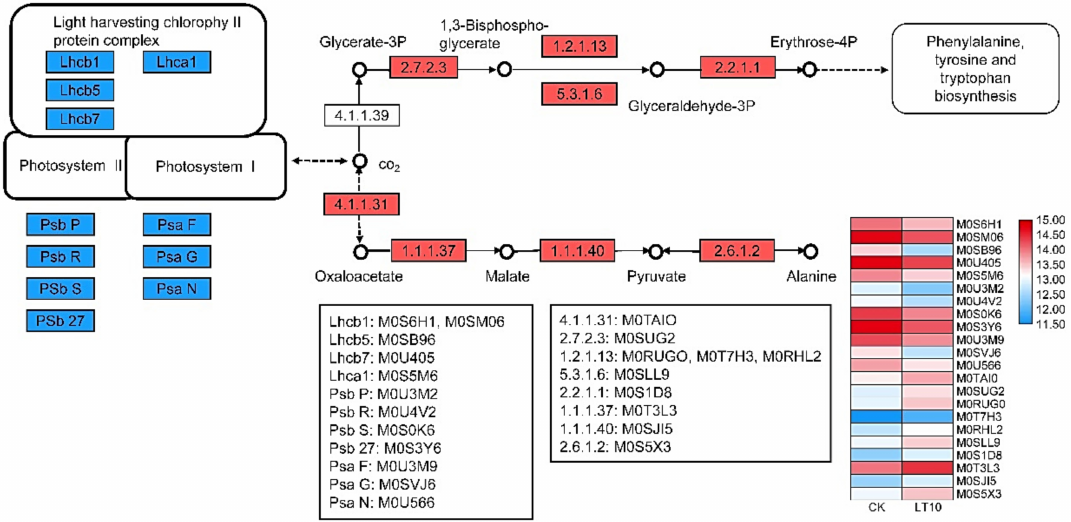
Figure 5. Diagram showing the abundance trends of photosynthesis-related proteins in banana ( Musa spp. AAA) in response to 10 ◦ C.